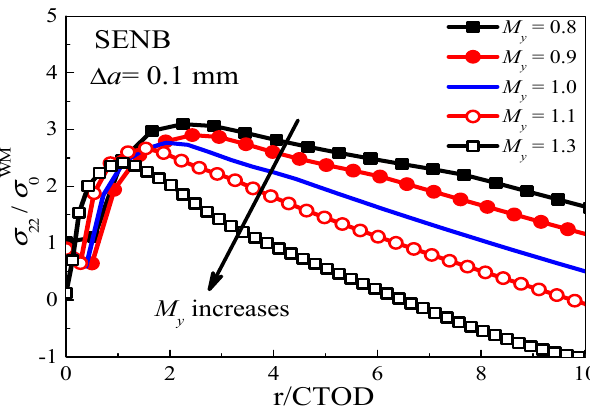
Figure 5. The distribution of crack tip opening stress ahead of the crack tip at ∆ a = 0.5 mm for different mismatched SENB specimens.